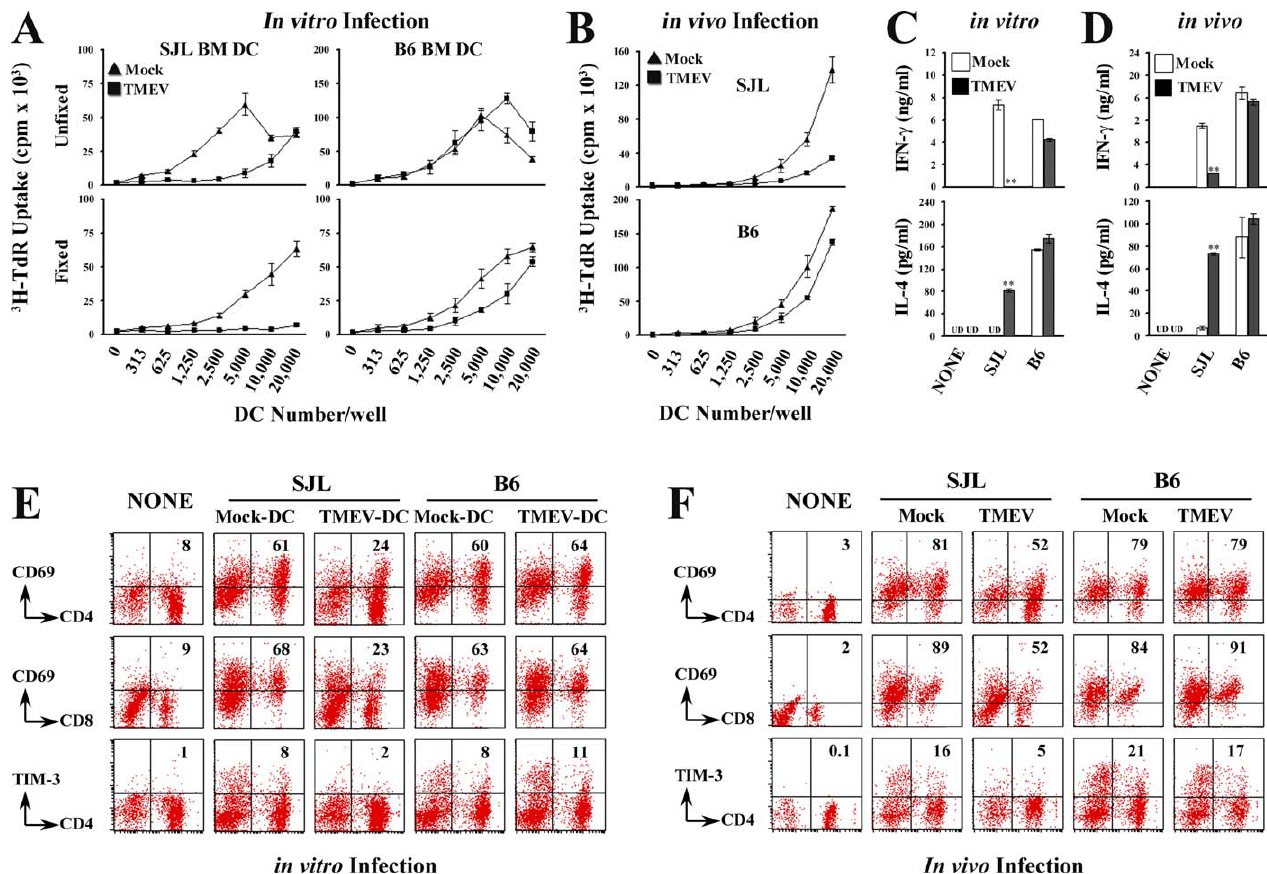
Figure 6. Inhibition of Allogenic T Cell Stimulation by TMEV-Infected DCs BM DCs were infected with TMEV in vitro for 3 d, and then varying numbers of unfixed or fixed BM DCs were cultured with 1 3 10 5 of naı¨ve T cells from BALB/c mice. To study in vivo infected cells, DCs were isolated from the spleens of mock- or TMEV-infected mice at 7 dpi, then co-cultured with naı¨ve T cells. Cells and culture supernatants were collected after 96 h of co-culture. (A, B) T cell proliferation was measured as the mean 6 SD of ( 3 H)-thymidine uptake from triplicate cultures. (C, D) IFN- c and IL-4 produced in culture supernatants (DC:T ¼ 1:10) were determined by ELISA. UD, undetectable. **, significant differences between the values in TMEV- and mock-infected cultures ( p , 0.01). Data from BM DCs infected in vitro are shown in (C), and those from infected mice in (D). (E, F) The effect of co-culture with infected DCs on the expression of CD69 or TIM-3 on T cells (DC:T ¼ 1:10) was determined by FACS. The numbers represent the percentage of CD69- or TIM-3-positive cells relative to total CD4 þ or CD8 þ T